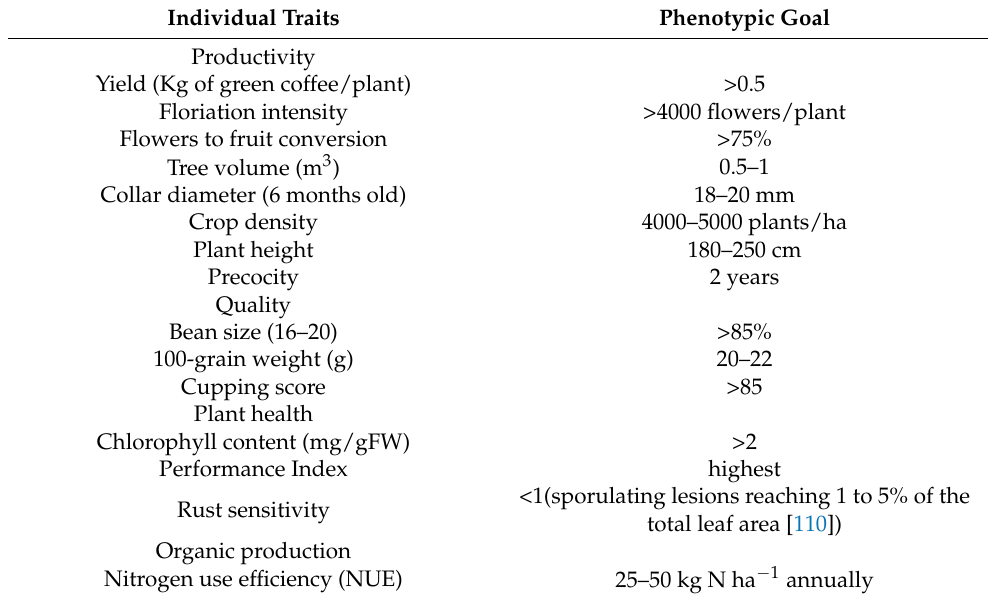
Table 2. Proposed ideotype for 15 traits of coffee hybrids to be grown in agroforestry systems. Individual Traits Phenotypic Goal